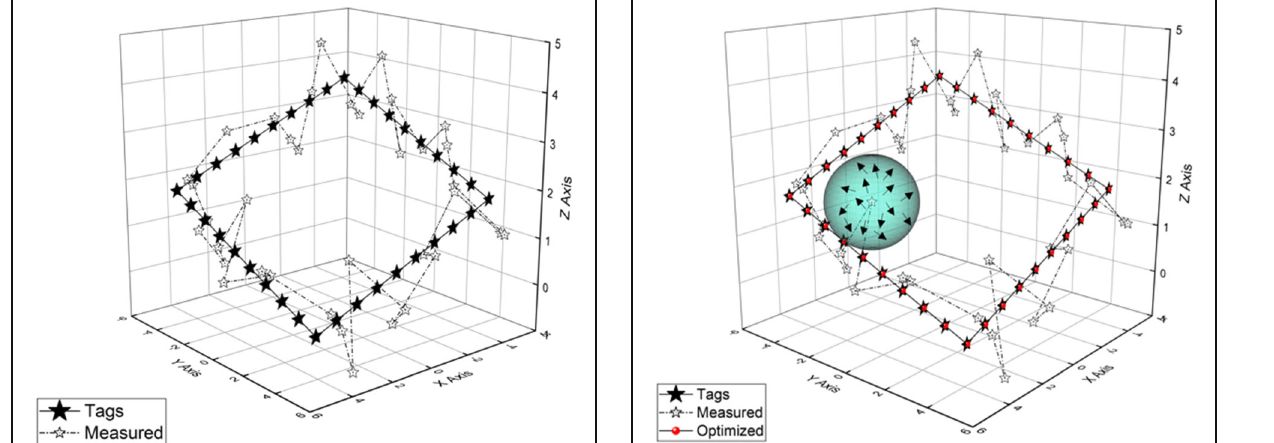
Fig. 12 3D indoor localization configuration. In this experiment, there are 36 targets supposed to localize in three-dimensional space, which are represented by black pentagonal stars. Then, we achieve 36 promising position measured by communication method mentioned